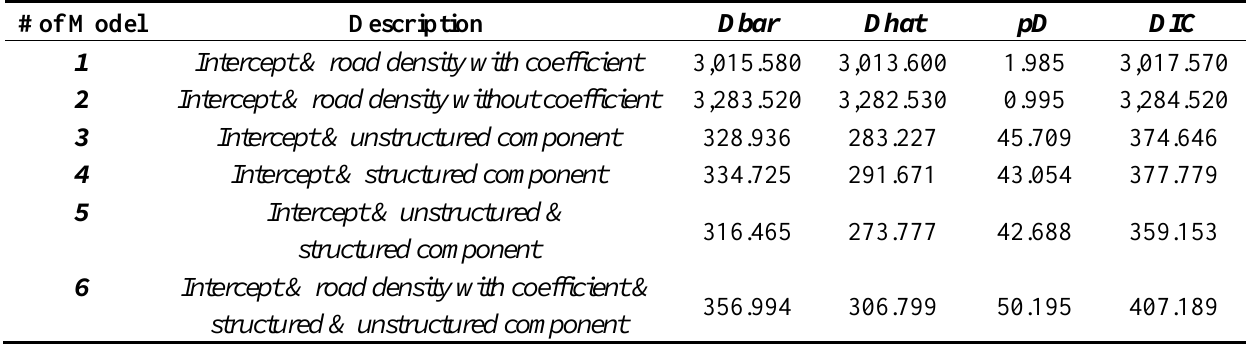
Table 3. The results of hierarchical Bayesian models from WinBUGS with different complexities. # of